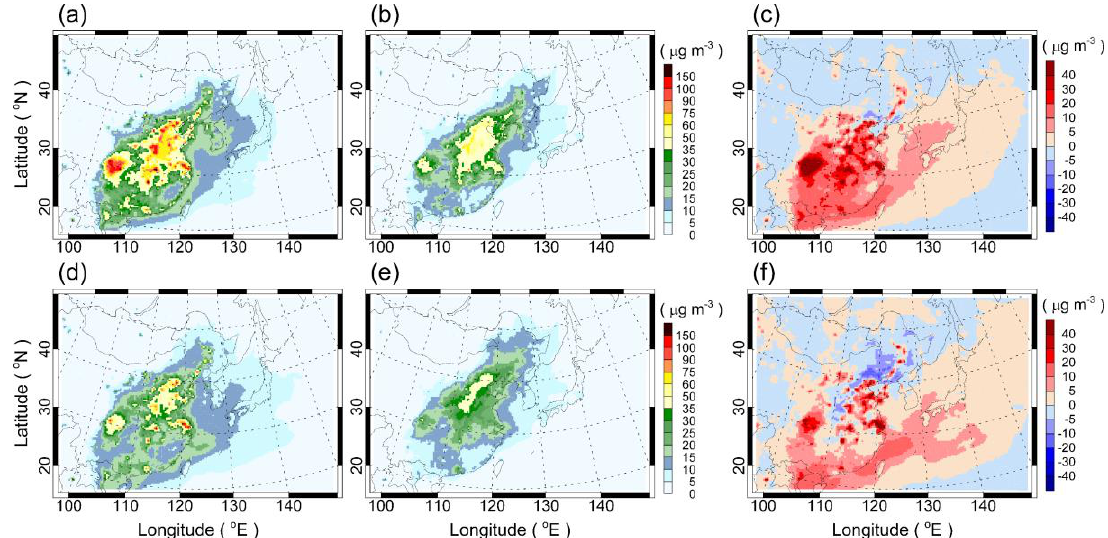
Figure 6. Spatial distributions of the surface PM 2.5 concentrations simulated by the ( a ) WRF-Chem and ( b ) WRF / CMAQ models and ( c ) their concentration di ff erence. The spatial distributions of temporal standard deviations estimated from the ( d ) WRF-Chem and ( e ) WRF / CMAQ models and ( f ) their fractional di ff erence. The PM 2.5 was calculated by the sum of sulfate (SO 4 2 − ), nitrate (NO 3 − ), ammonium (NH 4 + ), organic aerosols (OA), elemental carbon (EC), and other non-reactive PM 2.5 components (Others).